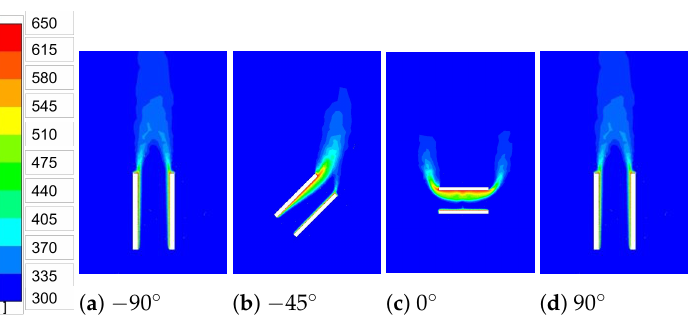
Figure 20. Section temperature contour views of the cylindrical through cavity receiver. Cavity: isothermal copper at 650 K; external receiver surface: isothermal at 300 K, adiabatic; body: incom- pressible ideal gas, ambient air at 300 K.